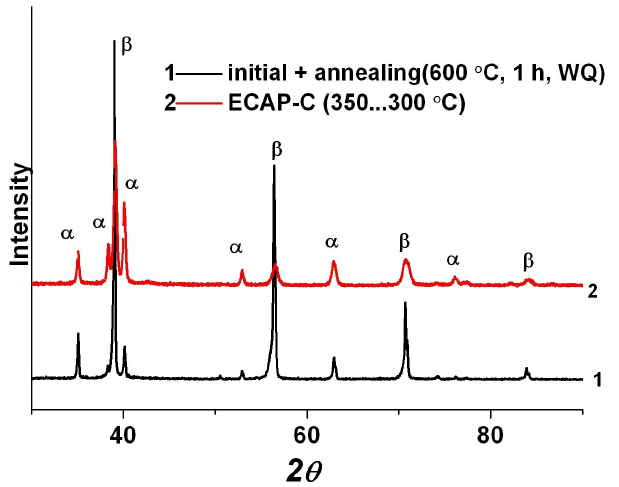
Figure 5. XRD patterns of the Ti-15Mo alloy after annealing at 600 °C for 1 h and after ECAP-C.